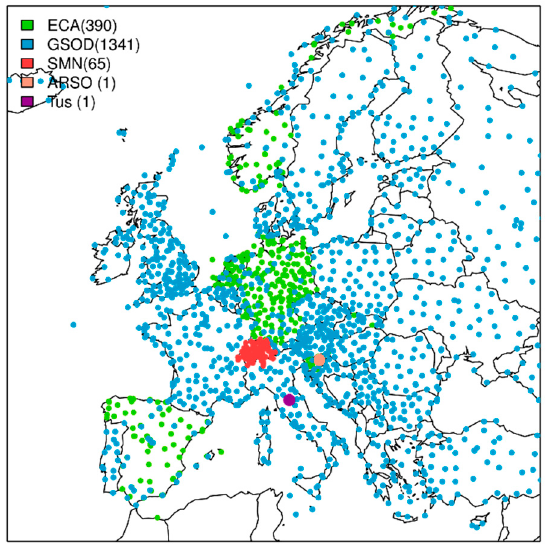
Figure 1. European stations which comprise the observational dataset of the HEAT-SHIELD platform, from ECA & D (green), GSOD (blue), SMN (red), ARSO (pink) and Tuscany from ECA & D (green), GSOD (blue), SMN (red), ARSO (pink) and Tuscany (purple).